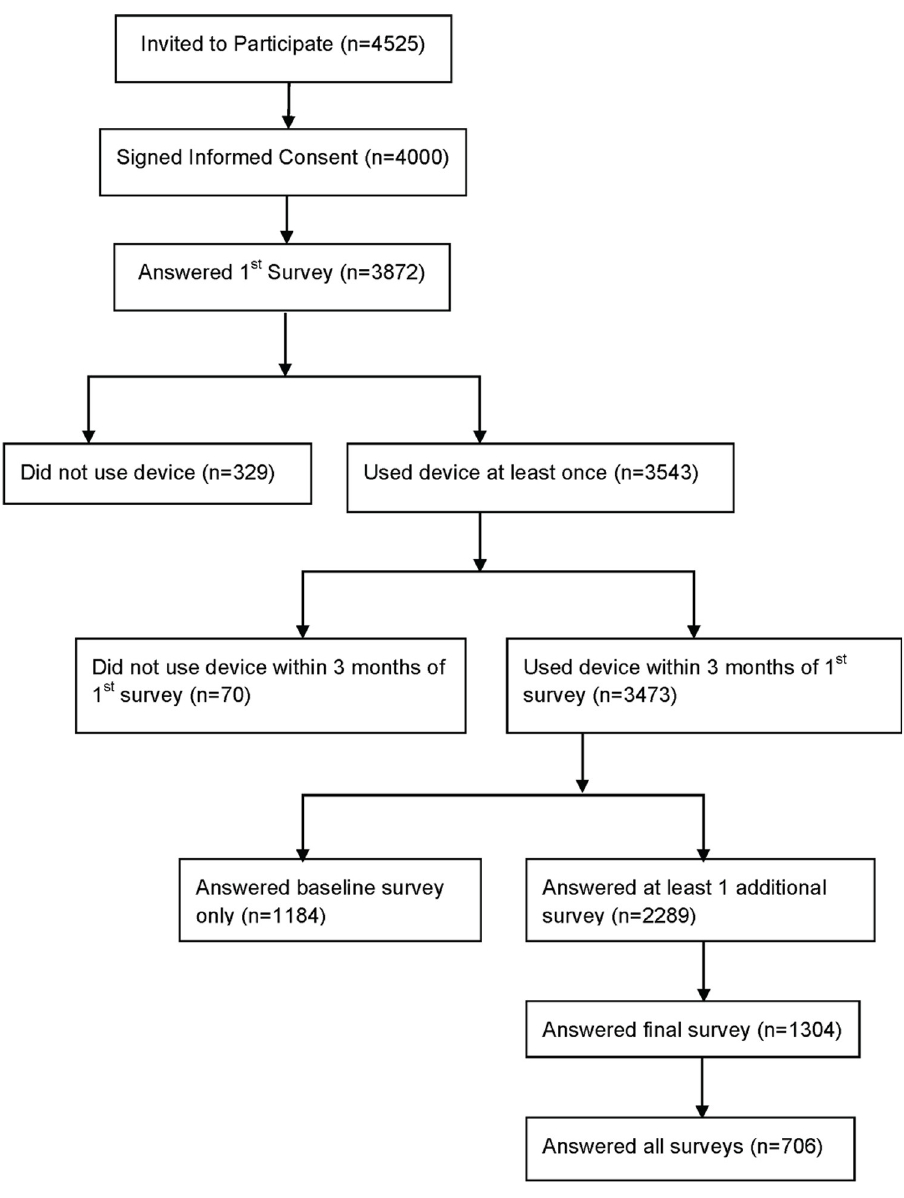
Fig 3. Participant flow